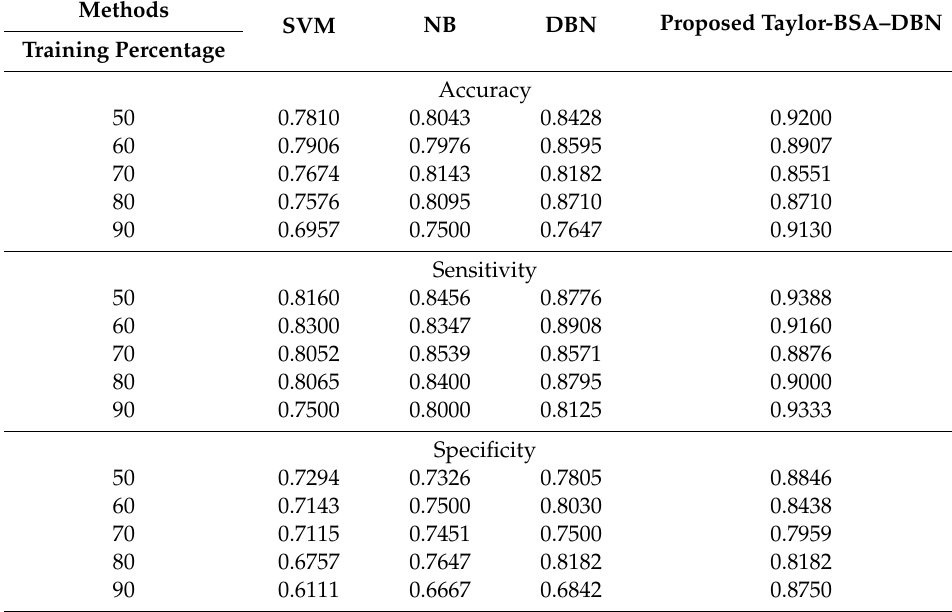
Table 3. Analysis of methods with cluster size = 5 using the Hungarian